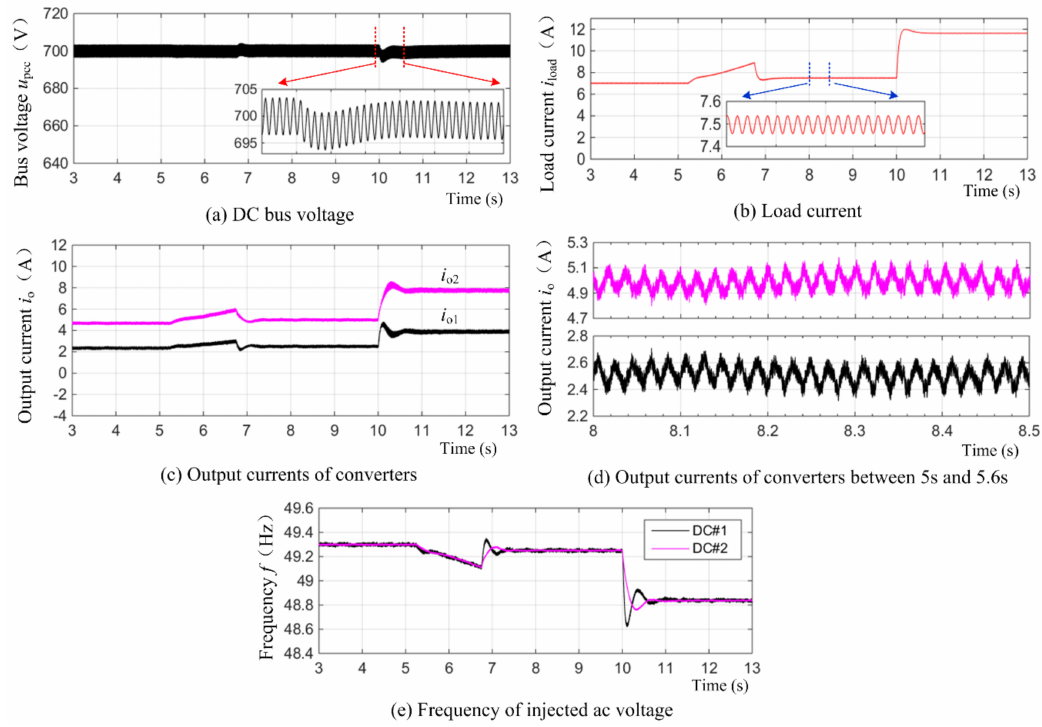
Figure 11. Simulation results of two unequal converters under the motor-based constant power